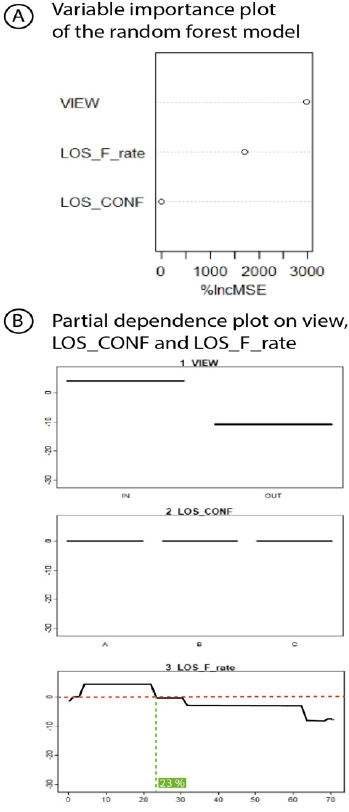
Figure 18. Random forest